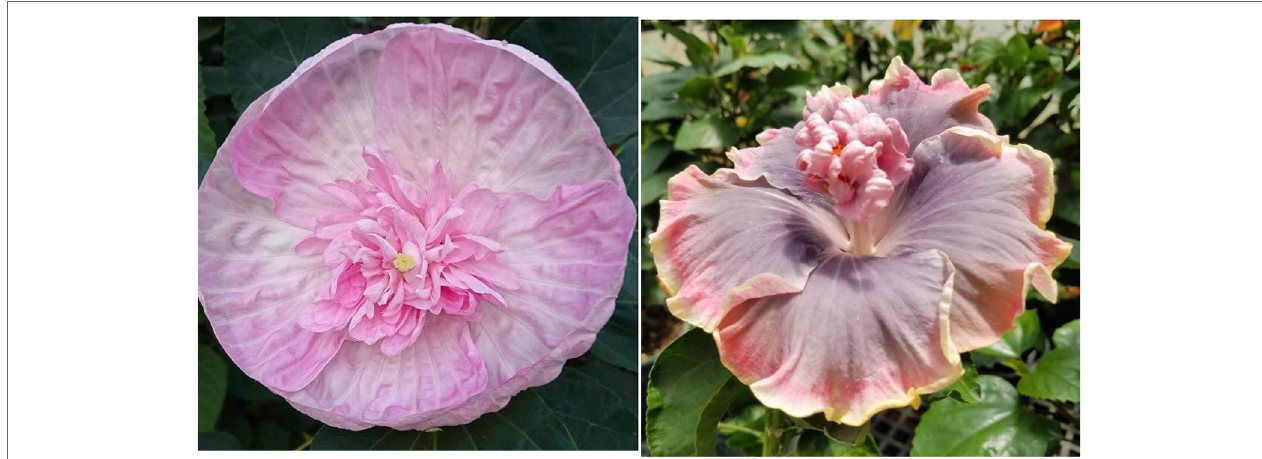
FIGURe 12 | Flower shape of H. moscheutos “Serdzse Matery” (left) and H. rosa-sinensis “Moorea Boondah Boo” (right). Photo credits: Lyudmila Zhurenko (“Serdzse Matery”) and Dariusz P. Malinowski (“Moorea Boondah Boo”). Used with permission.